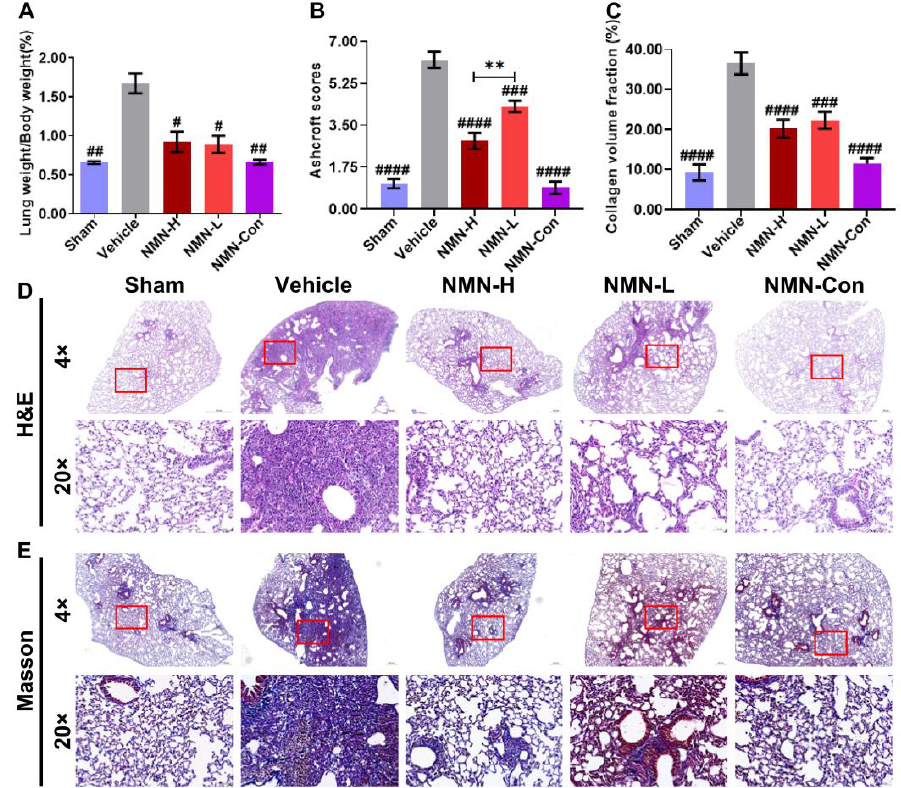
Figure 2. NMN intervention for 28 days ameliorates silica-induced lung injury in mice. ( A ) Lung weight coefficient (the ratio of lung wet weight to body weight) increased during injury induced by silica; ( B ) Ashcroft scores of lung tissue — associated with the severity of lung lesions — increased after silica induction; ( C ) collagen volume fraction of lung tissue — an indicator of collagen fibers expression in tissues — where silica induced deposition of collagen fibers’ in lung tissues; ( D ) H&E staining images of lung tissue; ( E ) Masson staining images of lung tissue. Scale: 4×, 20×, the images for 20× are derived from the red box in 4×. # indicates p < 0.05, ## p < 0.01, ### p < 0.001, #### p < 0.0001 vs. Vehicle; ** p < 0.01, NMN-H vs. NMN-L. Sham: saline + saline; Vehicle: silica + saline; NMN-H: silica + NMN (1000 mg/kg); NMN-L: silica + NMN (500 mg/kg); NMN-Con: saline + NMN (1000 mg/kg).